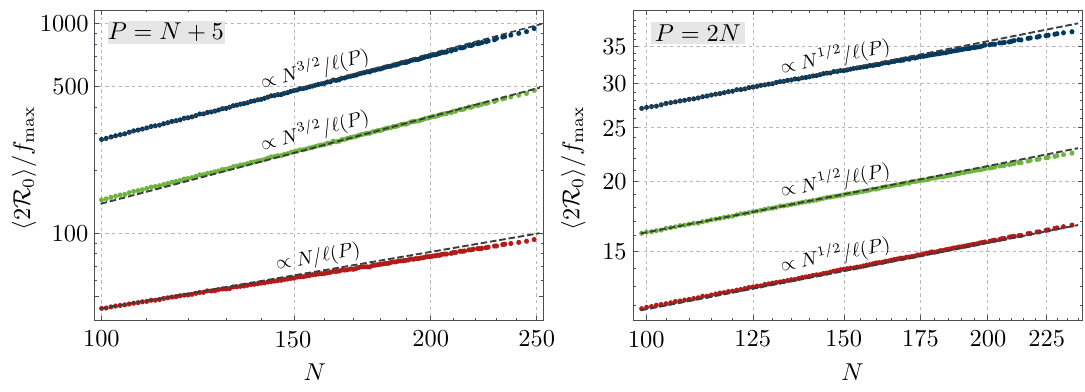
Figure 15 . Mean (cid:12)eld range along ^ (cid:9) for three ensembles of kinetic matrices K . The (cid:12)eld range Q j j along ^ (cid:9) is a signi(cid:12)cant lower bound on the diameter as explained in section 4.3.1. Left : the Q D 0 j j hard edge, P = N + 5. Right : soft edge, P = 2 N . Top, middle and bottom (blue, green and red) lines denote the unit kinetic matrix, Wishart and inverse Wishart ensembles with largest eigenvalue f 2 (set to 1 here). We chose (cid:27) = 7 =N . Dashed lines show the analytic max Q